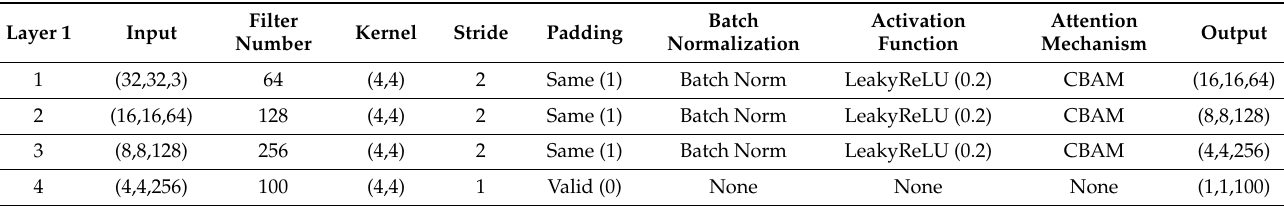
Table 2. Details of the decoder parameters.